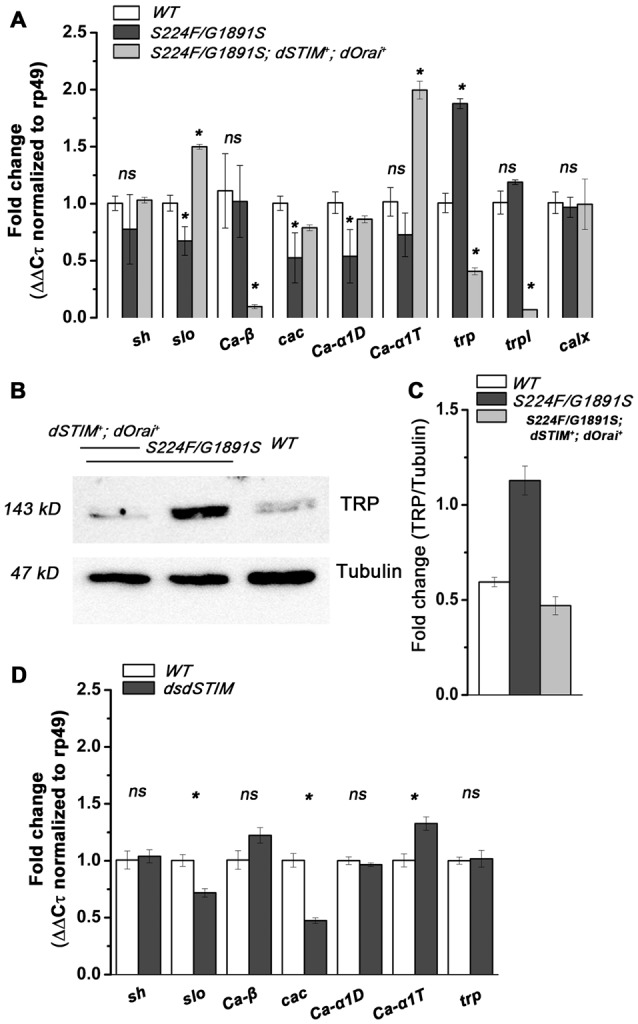
IP3R function/SOCE regulates expression of plasma membrane (PM) Ca2+ channels in Drosophila pupal neurons. (A) Fold change (ΔΔCτ normalized to rp49 mRNA, mean ± SEM) of mRNA levels for Slowpoke and Shaker, subunits of VGCCs (Ca-β, cacophony/cac, Ca-α1D and Ca-αT), TRP channels (trp, trpl) and NCX (calx) in extracts derived from 48–50 h pupal central nervous system in the respective genotypes, N = 3, Student’s t-test. (B) Representative western blot showing expression of TRP in the respected genotypes. (C) Fold change of TRP protein expression (mean ± SEM) in the respective genotypes, N = 3, Student’s t-test. (D) Fold change (ΔΔCτ normalized to rp49 mRNA, mean ± SEM) of mRNA levels for Slowpoke and Shaker, subunits of VGCCs (Ca-β, cacophony/cac, Ca-α1D and Ca-αT) and TRP in the respective genotypes, N = 3, Student’s t-test. *P < 0.05.